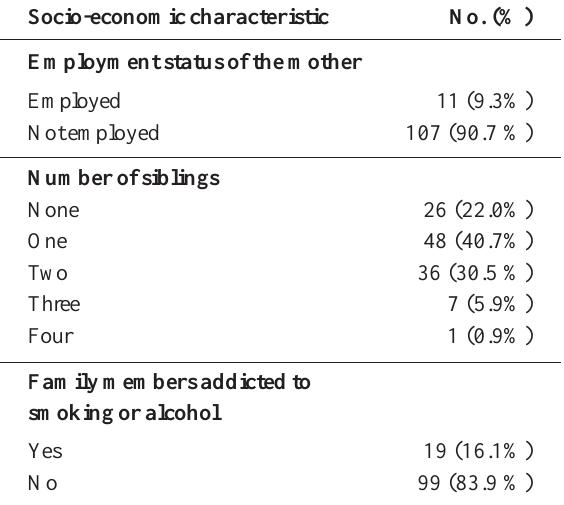
Table 1. Socio-economic characteristics of the parents of cases and controls (N=118)